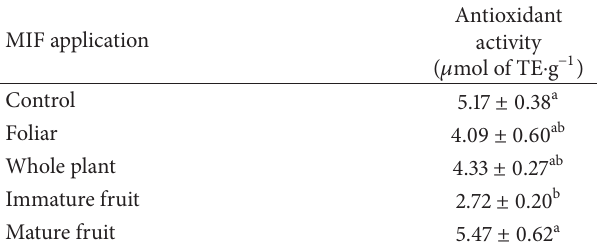
Table 3: Radical scavenging activity of sweet bell pepper as a result of MIF application ∗